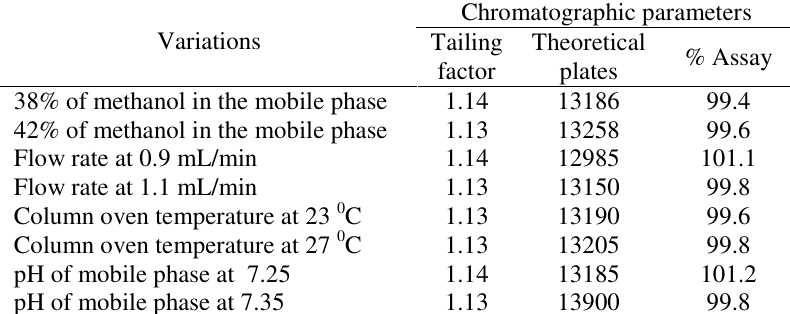
Table 4. Results of the robustness study